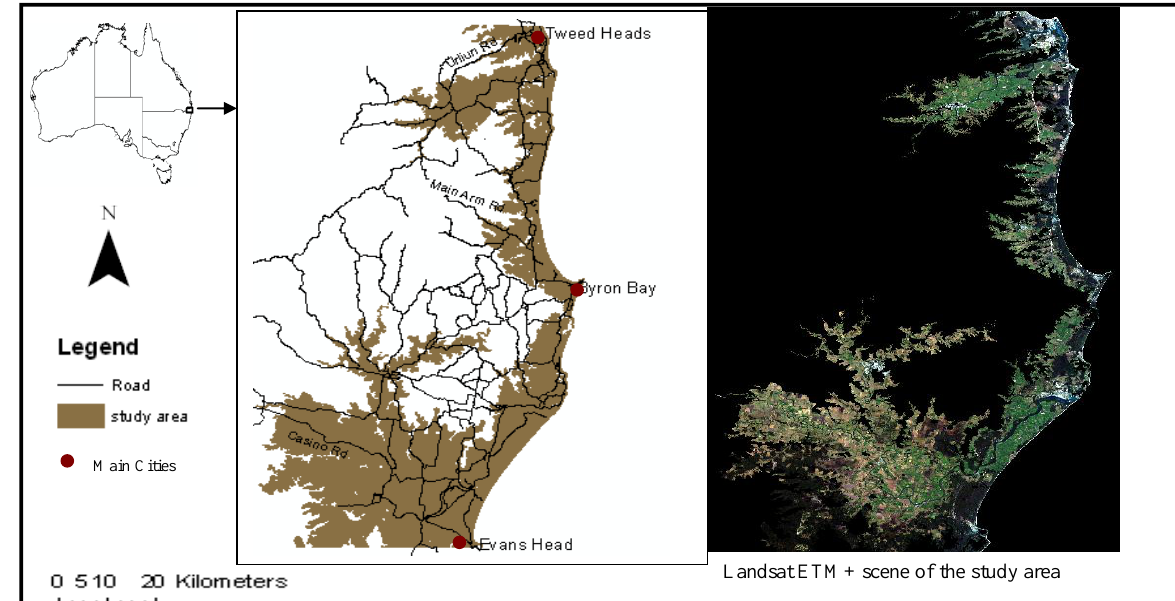
Figure 1. Study Area: north-eastern NSW Australia.